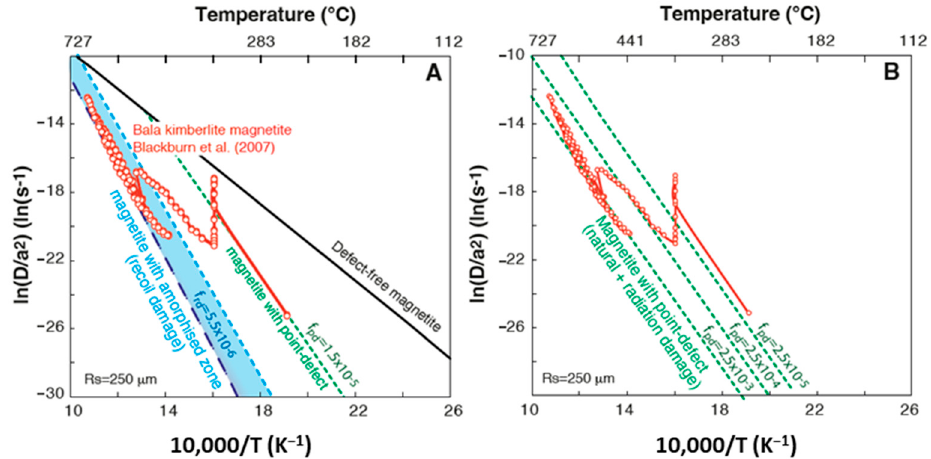
Figure 4. Arrhenius diagram (ln(D/a 2 ) vs. 10,000/T) comparing He diffusion data obtained experimentally on a Bala Kimberlite magnetite grain [17] with the results of our calculations. ( A ) He diffusion properties obtained using DFT calculations, for a sphere equivalent radius of 250 µ m, for defect-free magnetite (black line), and magnetite with point defect (green dashed line) and recoil damage (E a = 2.1 eV (light blue dashed lines) and 2.28 eV (dark blue dashed lines), with a g factor of 0.023) concentrations estimated for Bala magnetite, (cid:102) D 0 using activation energies from Table 1 and frequency factors of 3.07 × 10 − 3 , 2.7 × 10 2 , and 1.8 × 10 3 cm 2 /s, respectively. ( B ) He diffusion properties obtained using DFT calculations, for a sphere equivalent radius of 250 µ m, with different point defect fractions of 2.5 × 10 − 5 , 2.5 × 10 − 4 and 2.5 × 10 − 3 , that will be associated with the combination of radiation damage induced point defects and point defects formed during magnetite crystallization (named here natural point